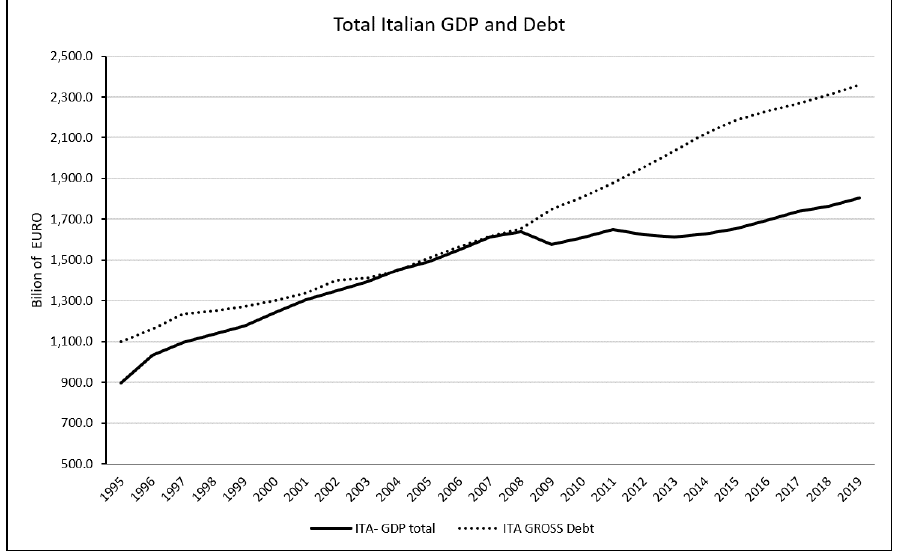
Figure 6. Italian Gross Debt and the total gross domestic product (GDP) for the period from 1995:Q1 to 2019:Q2. (data source: Bank of Italy, 2019, ‘own